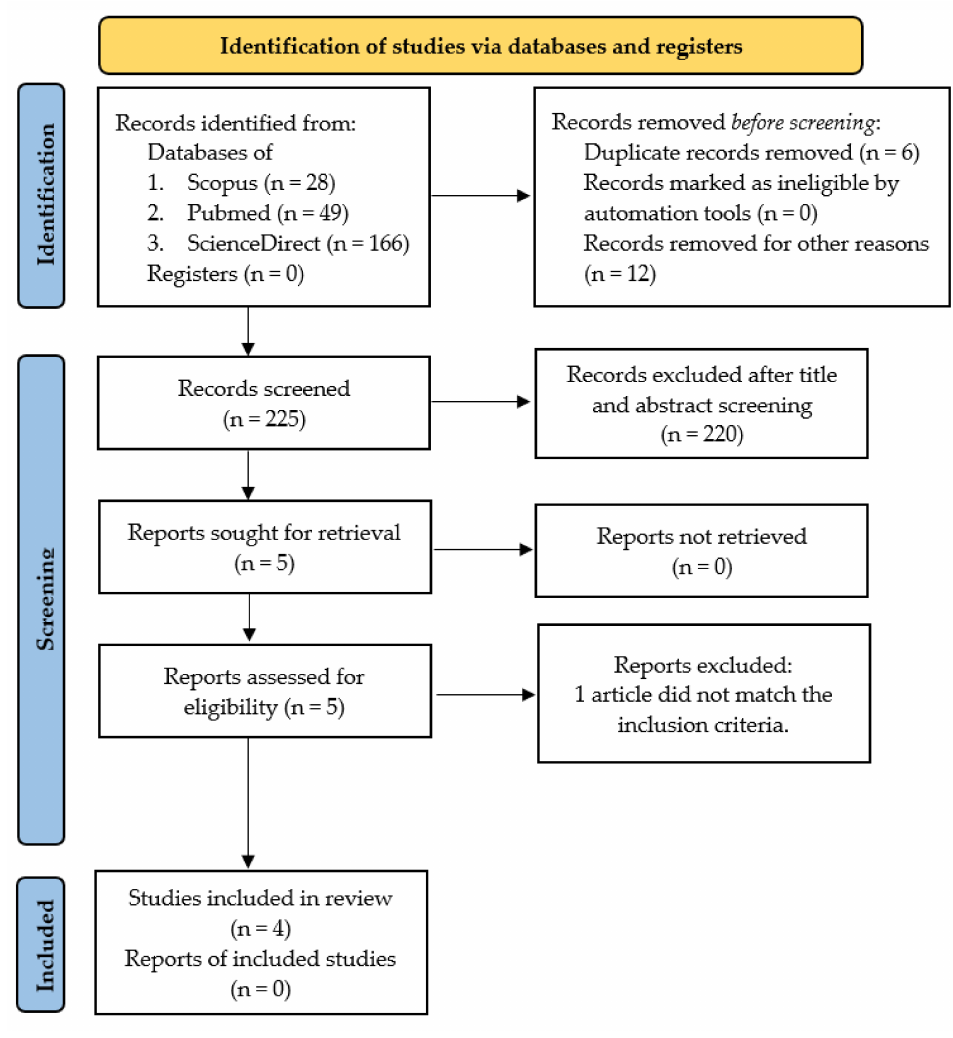
Figure 1. PRISMA flow diagram